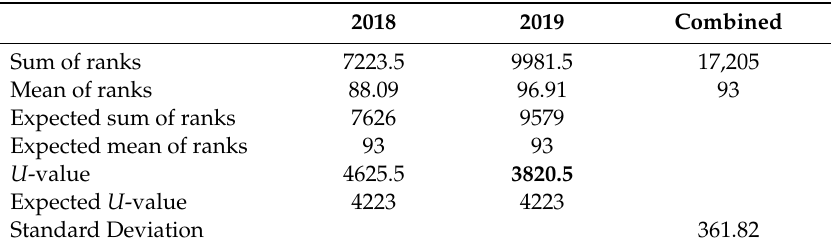
Table 10. Mann-Whitney U-test results.